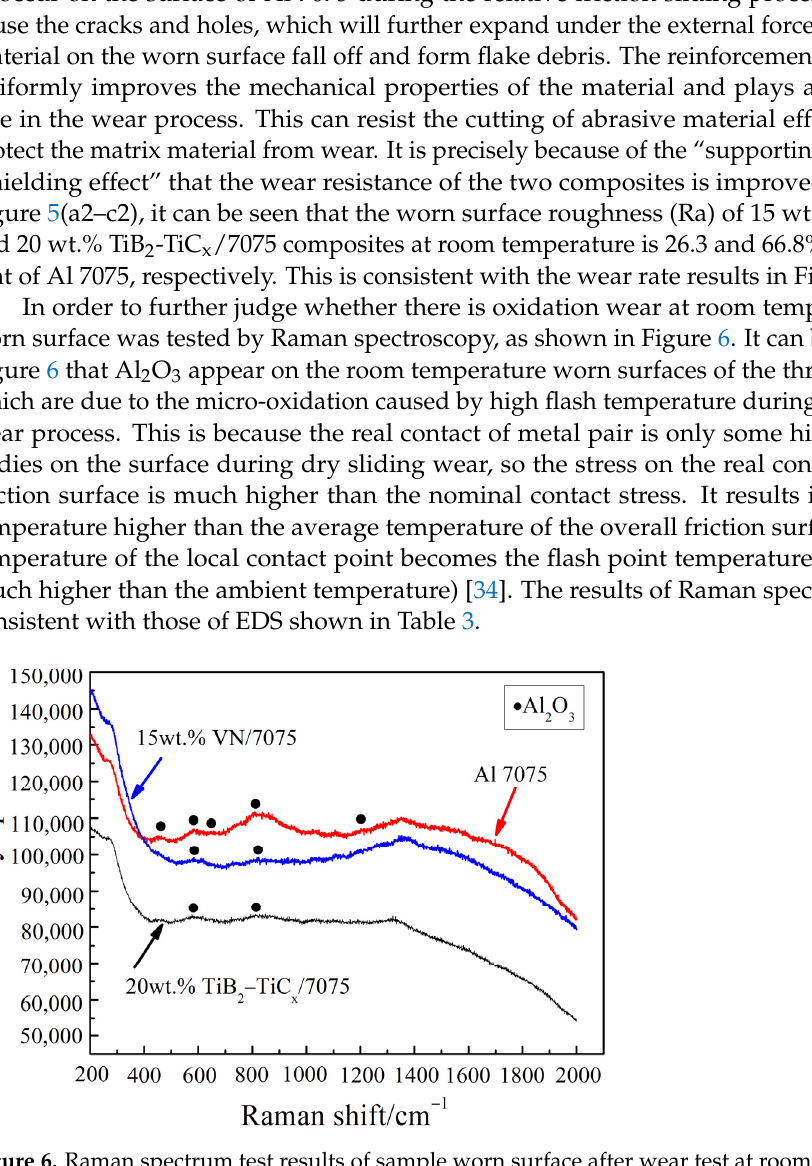
Table 3. EDS results (wt.%) in regions 1–3 indicated in Figure 5.